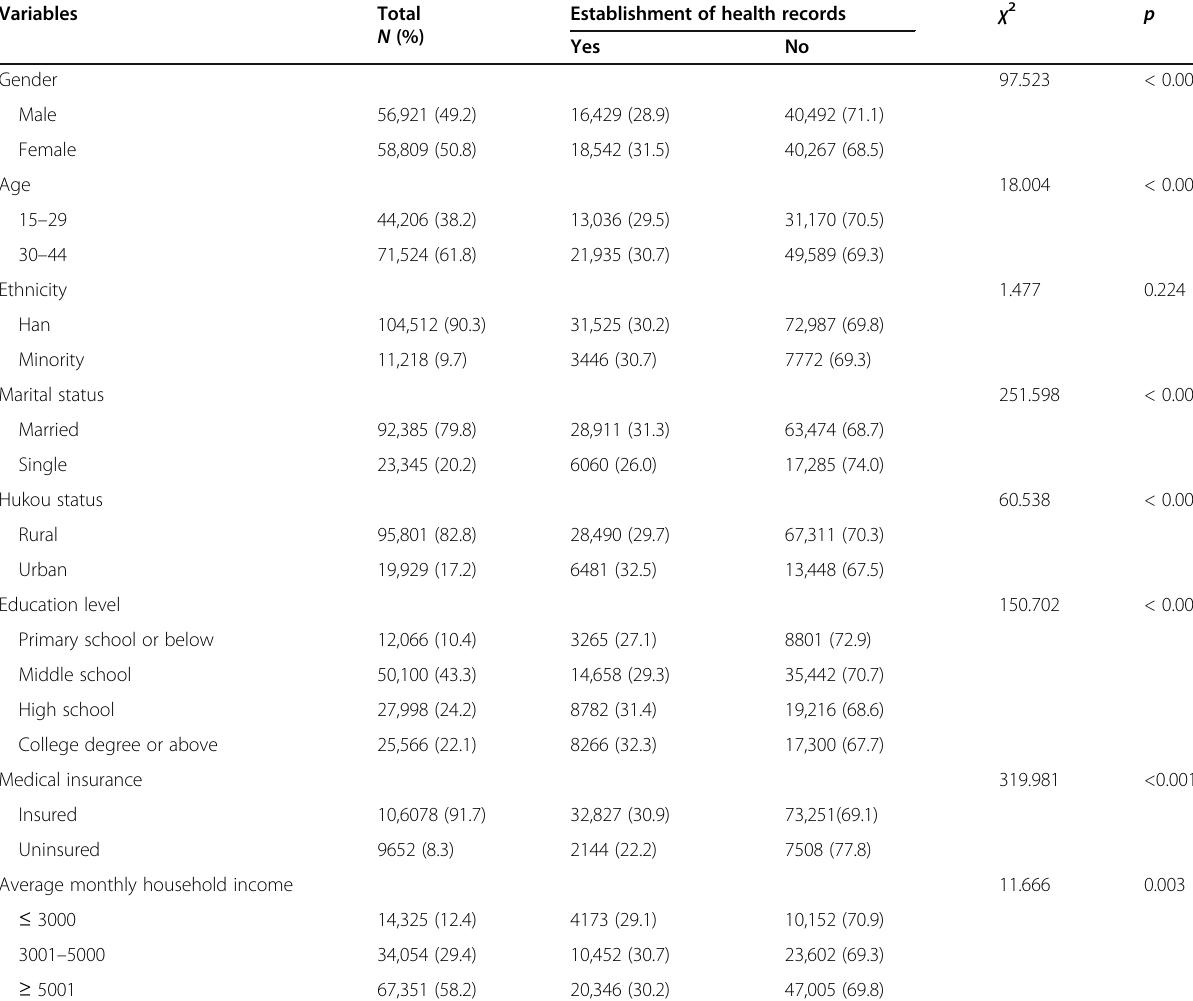
Table 1 Sociodemographic characteristics and the establishment of health records ( N = 115,730) Variables